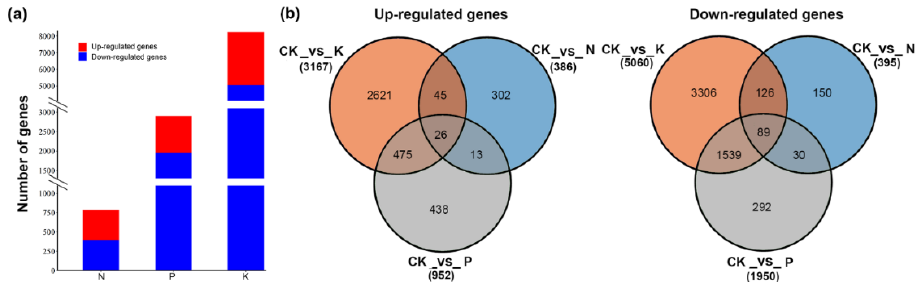
Figure 1. The distribution of differentially expressed genes under nitrogen (N), phosphate (P), and potassium (K) starvation. ( a ) The number of differentially expressed genes under N, P, and K starvation. ( b ) The number of up-regulated genes specific to and overlapping in N, P, and K starvation. ( c ) The number of down-regulated gene specific to and overlapping in N, P, and K starvation.